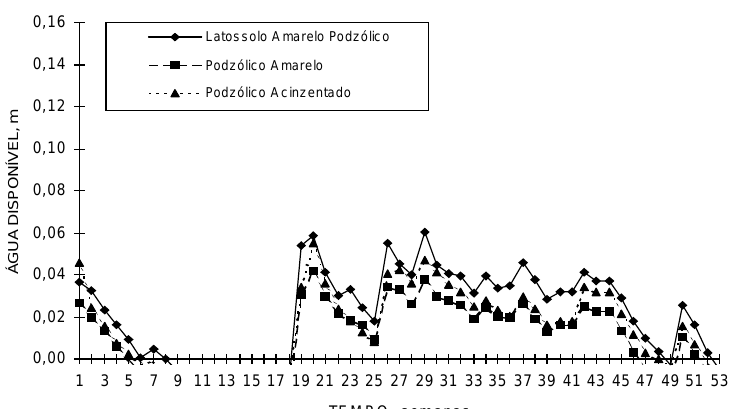
Figura 5. Água disponível até 0,70 m de profundidade, durante o período de um ano, a partir de 18 de dezembro de 1995, em uma toposseqüência de solos de tabuleiro cultivados com citros, no município de Sapeaçu